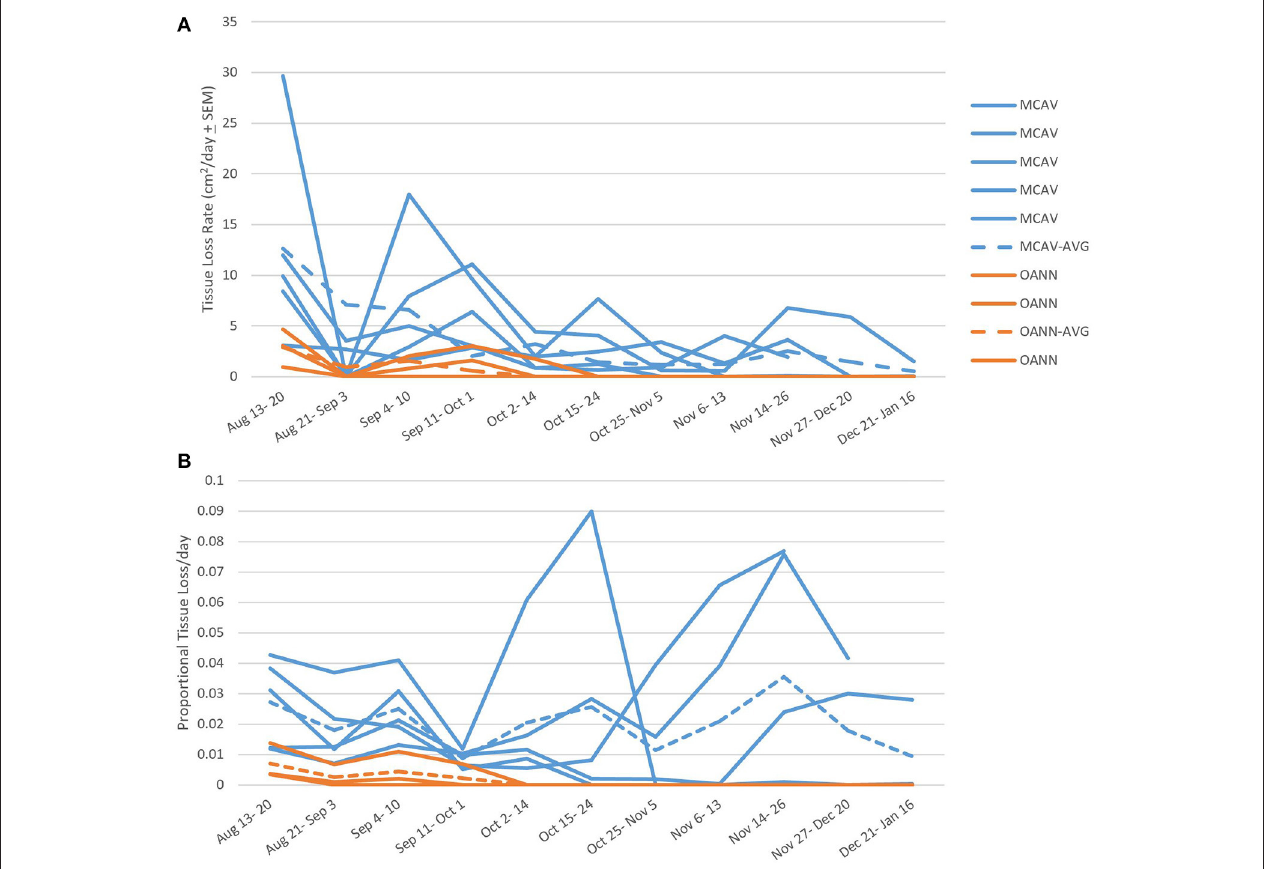
FIGURE 7 | Species specific tissue loss rates. (A) Tissue loss rates among species calculated before, during, and after the bleaching event. Individual colony rates are marked with solid lines, while the average for the species is marked with a dashed line. There was a significant difference in tissue loss rate between species and decline in rate over time. MCAV, Montastraea cavernosa ; OANN, Orbicella annularis ; Combined: average of the two species combined. (B) Proportional tissue loss rate among species calculated before, during, and after the bleaching event. Individual colony rates are marked with solid lines, while the average for the species is marked with a dashed line. There was no difference in proportional tissue loss rates between species nor over time over the bleaching event.